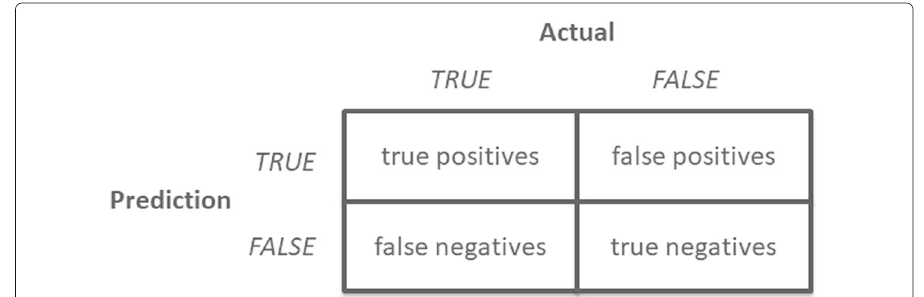
Fig. 7 Confusion matrix for two classes true and false . The result of each classification task can be classified in one of these 4 categories. The results for each category are summed up for further calculations